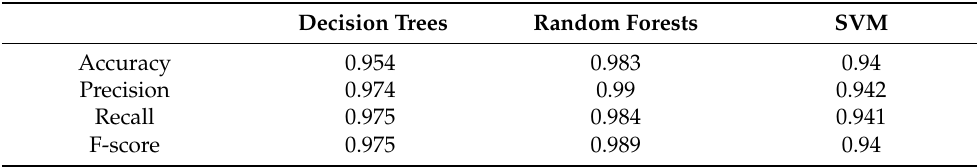
Table 2. Road surface conditions classification